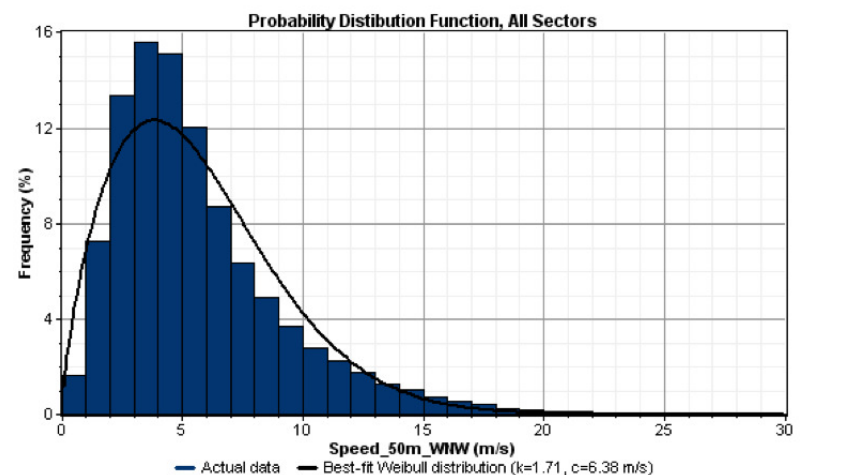
Figure 10. Wind frequency distribution at 50 m with its Weibull fitting—FPL-01 station.